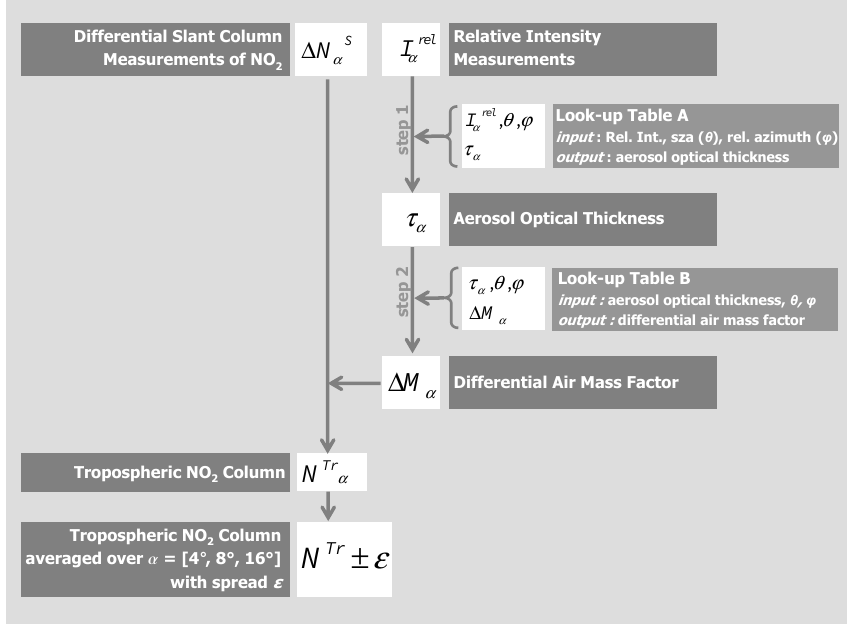
Fig. 5. Flow chart of the two-step retrieval algorithm of tropospheric NO 2 columns. will also have the largest effect for the smallest